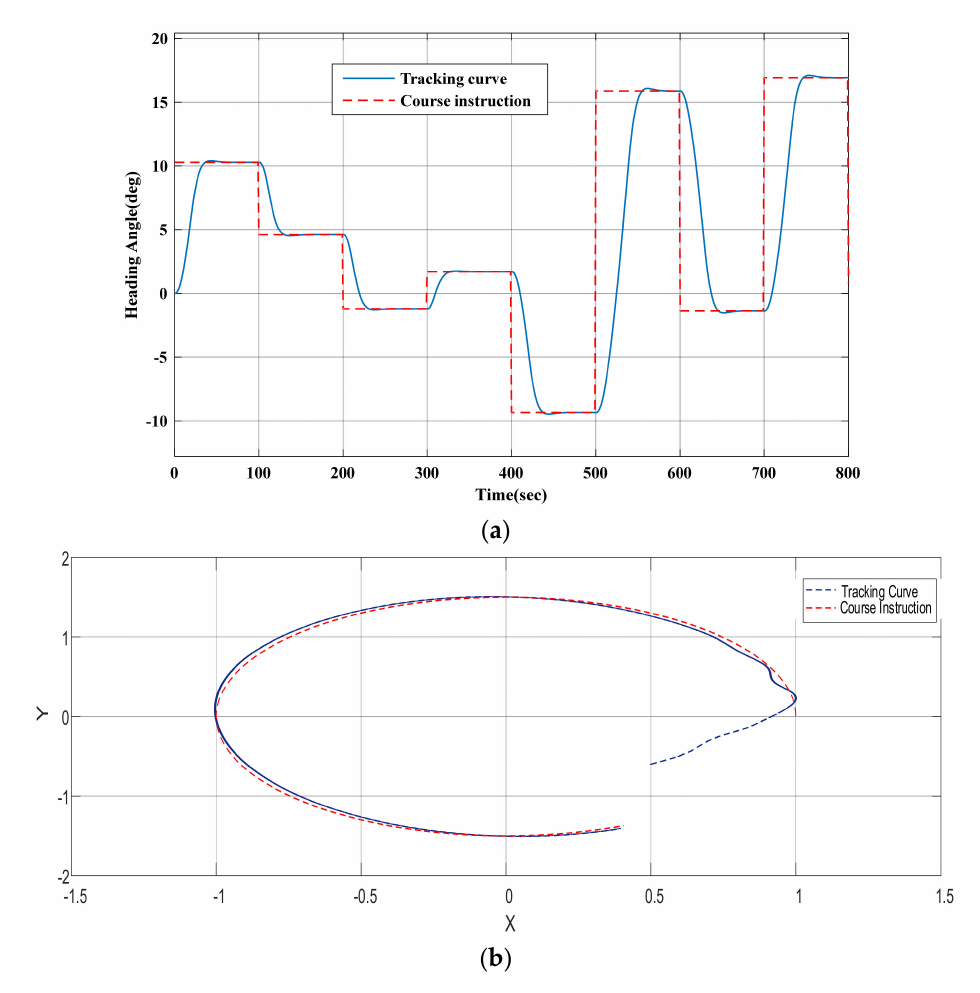
Figure 5. Tracking response of the neuro-fuzzy controller. ( a ) Frequent turn tracking; ( b ) Elliptic trajectory